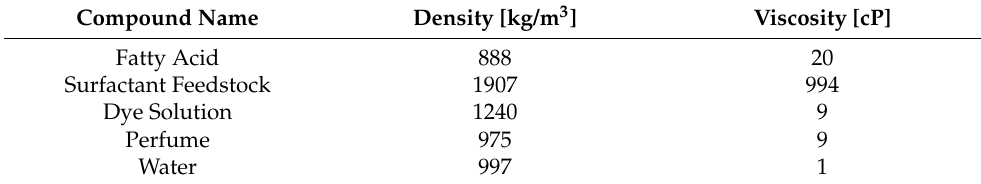
Table 1. Compounds’ density and viscosity values.